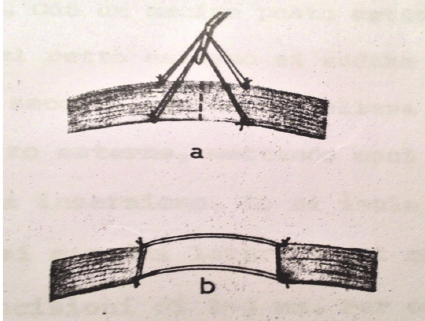
Figure 1: Controlled Myotomy by plastic bridge sutures.